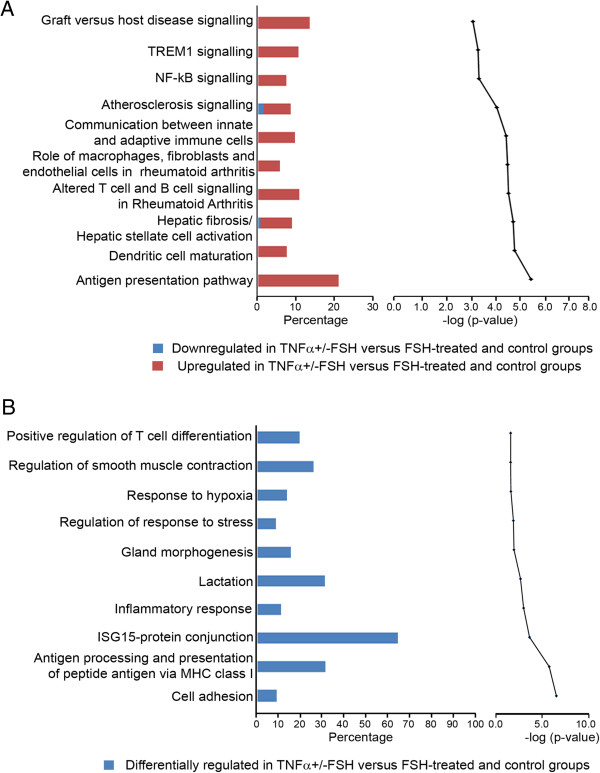
Top ten canonical pathways and highly enriched GO terms. Determined for genes differentially regulated between control (± FSH) and TNFα (± FSH)-treated granulosa cells (n = 527 probe sets, 379 genes mapped to IPA). In (A) the bar charts represent the percentage of genes from the dataset that map to each canonical pathway in IPA (up regulated in red and down regulated in blue for TNFα (± FSH)-treated granulosa cells). The line chart ranks the pathways derived from the highest to lowest degree (bottom to top) of association based on the value of a Benjamini-Hochberg test for multiple corrections. In (B) the bar charts represent the percentage of differentially-regulated genes between control (± FSH) and TNFα (± FSH)-treated granulosa cells. Only the most specific subcategories of GO terms under biological process which were considered significant by the Benjamini-Yuketeli test (P < 0.05) were ranked.